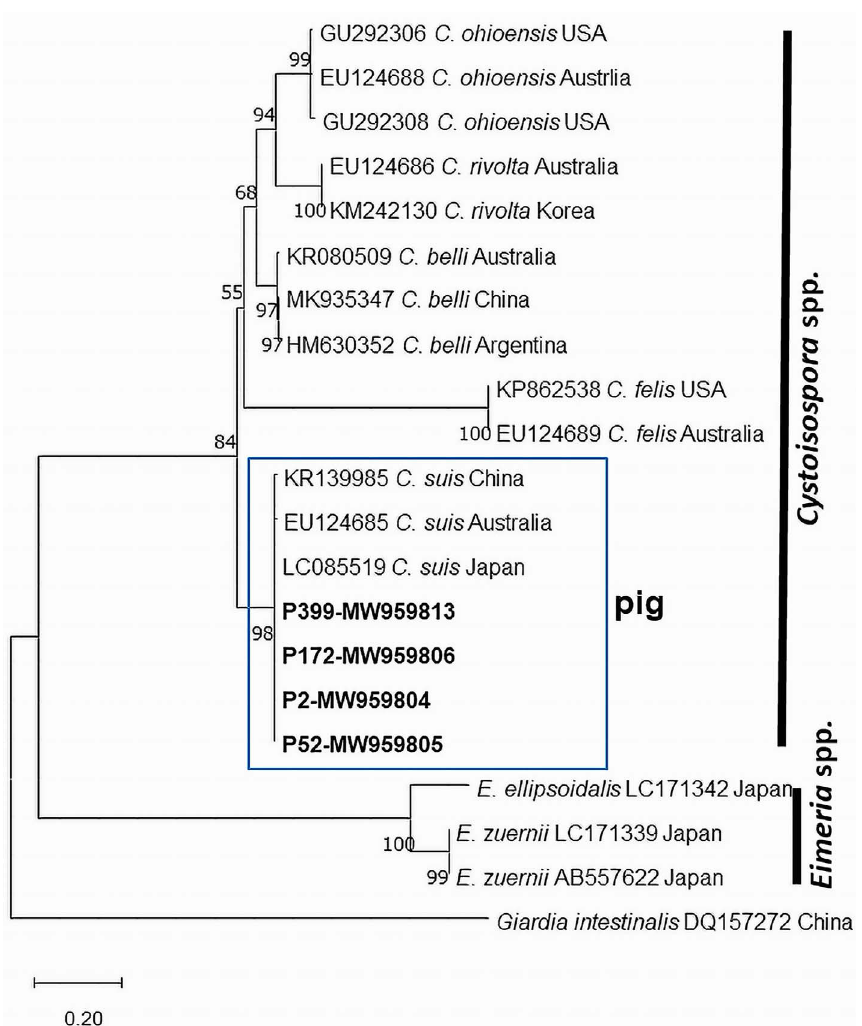
Figure 4. The phylogenetic relationships of partial ITS1 sequences of Cystoisospora suis detected in this study and reference sequences. The phylogenetic tree was constructed by the Maximum Likelihood method based on the Tamura-Nei model. The bold taxa represent the sequences obtained from the current study. GenBank accession number of each sequence is given. Bootstrap values were computed independently for the purposes of 1000